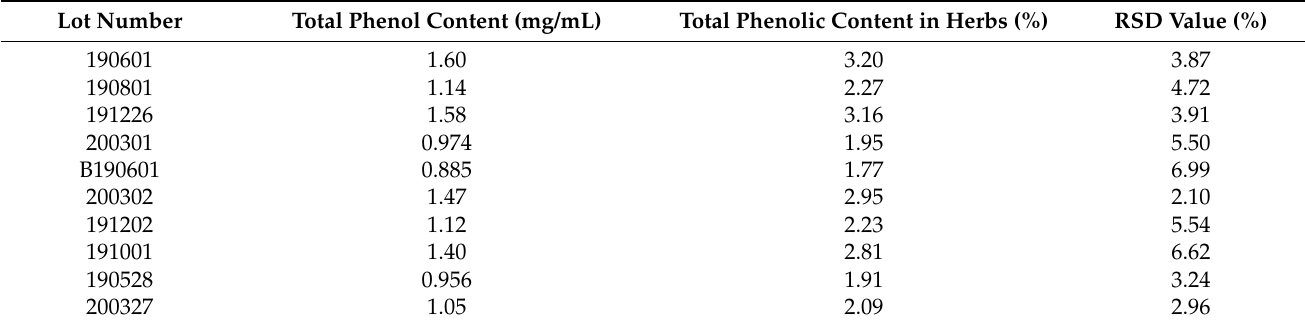
Table 5. Results of total phenol content in aqueous extracts of honeysuckle ( n = 3). Lot Number Total Phenol Content